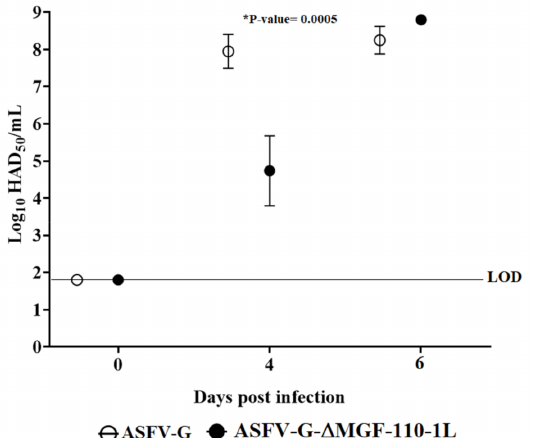
Figure 6. Viremia titers detected in pigs IM inoculated with 10 2 HAD 50 of either ASFV-G- ∆ MGF110- 1L (filled symbols) or ASFV-G (empty symbols). Each symbol represents the average of animal titers in each of the groups. Sensitivity of virus detection: >log10 1.8 TCID 50 /mL. Significant differences in viremia values between both groups of pigs were found at day four post-infection using the Holm-Sidak method ( α = 0.05) without assuming a consistent standard deviation. All calculations were conducted on the software Graphpad Prism version